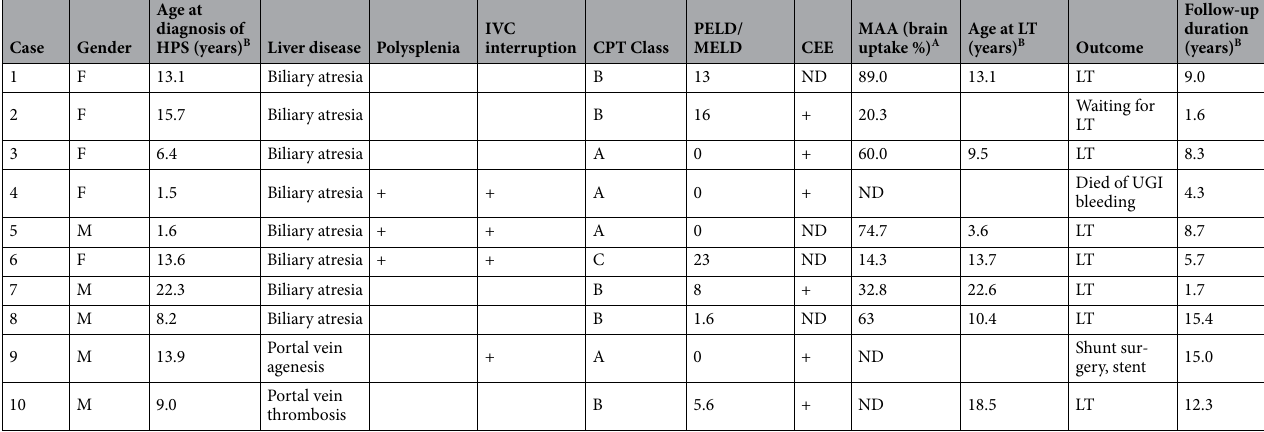
Table 1. Clinical details of patients with hepatopulmonary syndrome. CEE contrast echocardiography, CPT Child–Pugh-Turcotte, HPS hepatopulmonary syndrome, IVC inferior vena cava, LT liver transplantation, MAA macroaggregated albumin, MELD Model for End-Stage Liver Disease, ND not done, PELD Pediatric End-Stage Liver Disease, UGI upper gastrointestinal. A Absolute number (percentage). B Absolute number